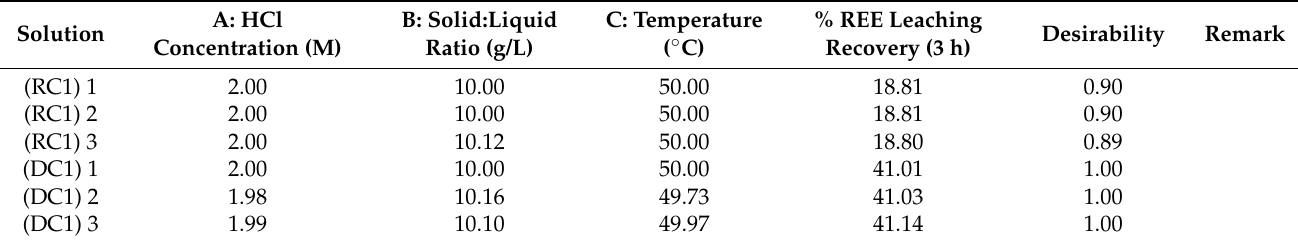
Table 8. Leaching conditions of the optimised solution for RC1 and